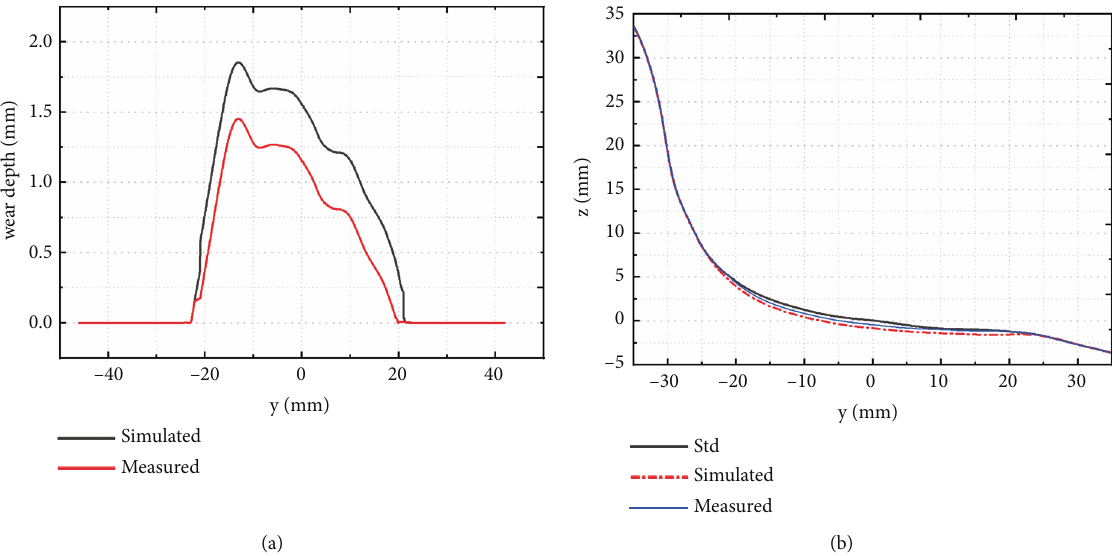
Figure 7: Comparison between simulated and measured wheel tread wear of Ethiopia — Addis Ababa Light Rail Transit (LRT) at the end vehicle for a mileage of 52,000km; (a) wear depth and (b) pro fi le